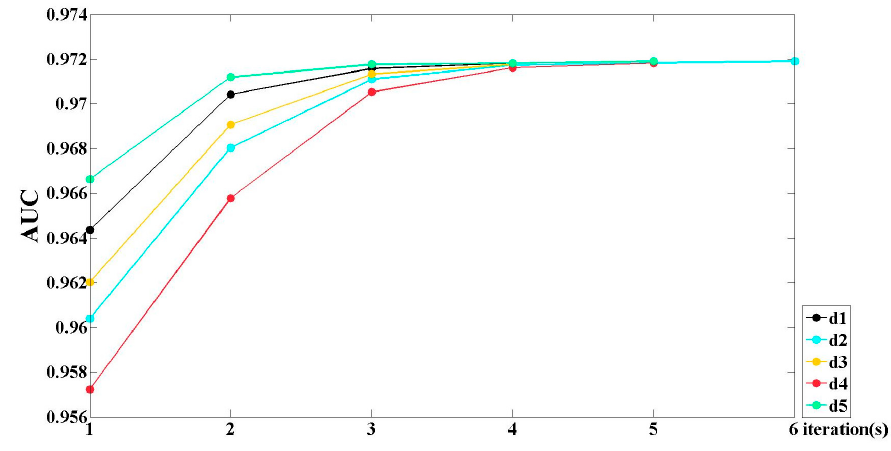
Figure 24. Iterative process of OSGP and corresponding AUC detection result.